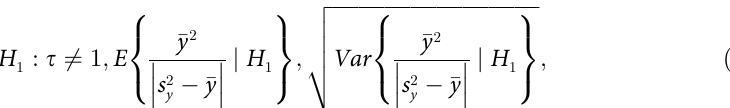
and correlations under H : τ 6¼ 1 in a situation in which the family gathering consists of attendees 1 having heterogeneous resistance to COVID-19 are computed and displayed in Tables 1 and 2.